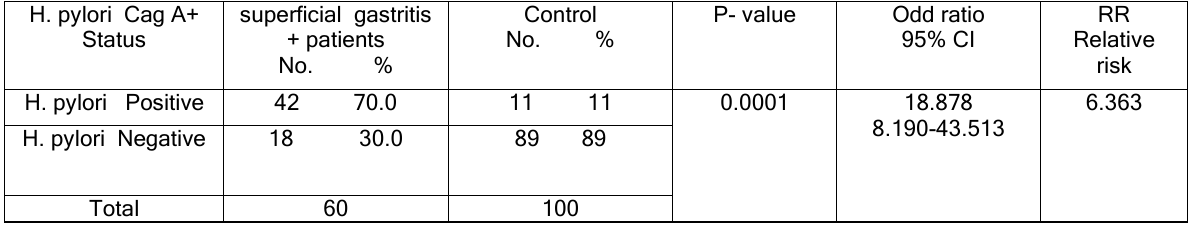
Table-1- Helicobacter pylori in superficial gastritis patients compared with control